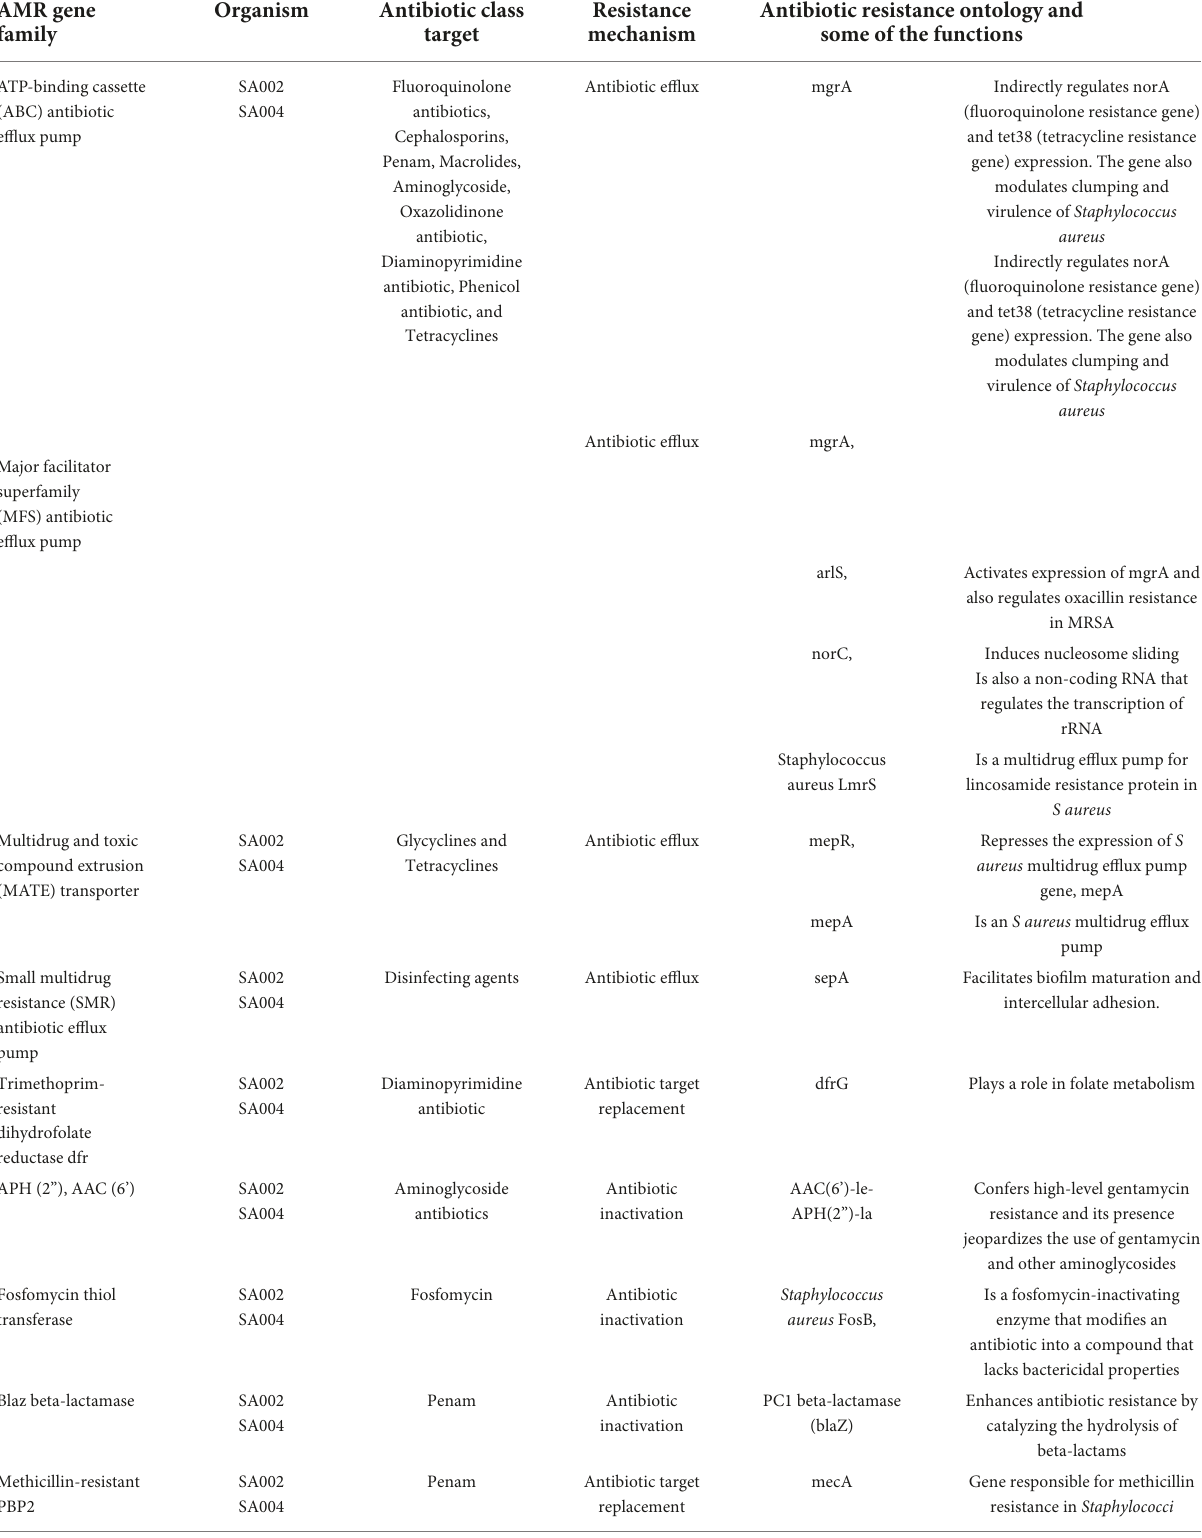
TABLE 3 AMR gene families detected in SA002 and